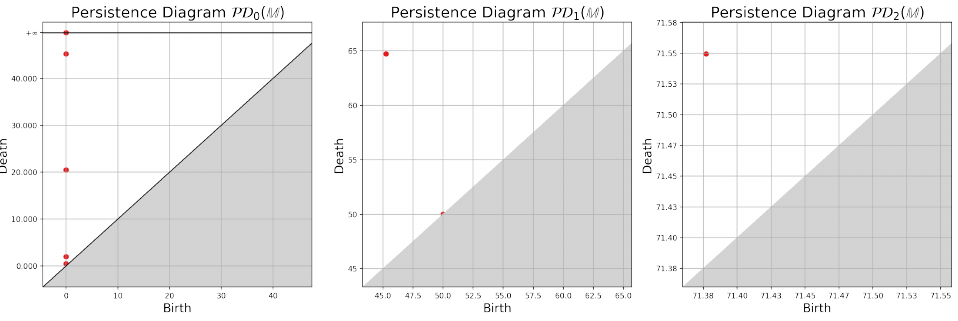
Figure 4. Persistence diagrams PD ( M )